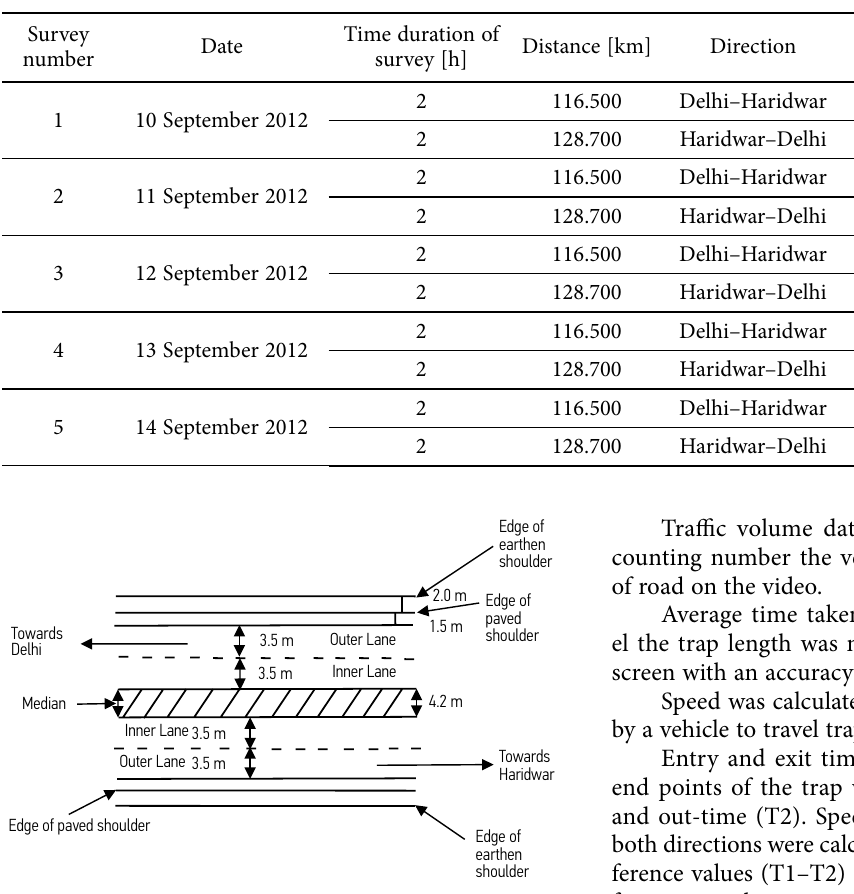
Table 1. Data set